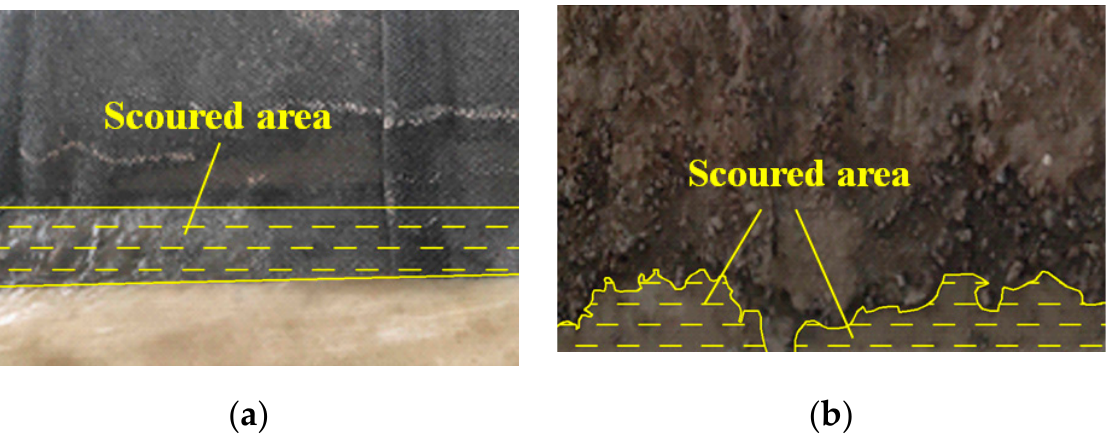
Figure 7. Soil erosion under different slope protection conditions: ( a ) initial stage of soil erosion at the slope foot (RUN 12, after 1 h scouring); ( b ) erosion shape of soil at the slope foot (RUN 9, after 40 h scouring).